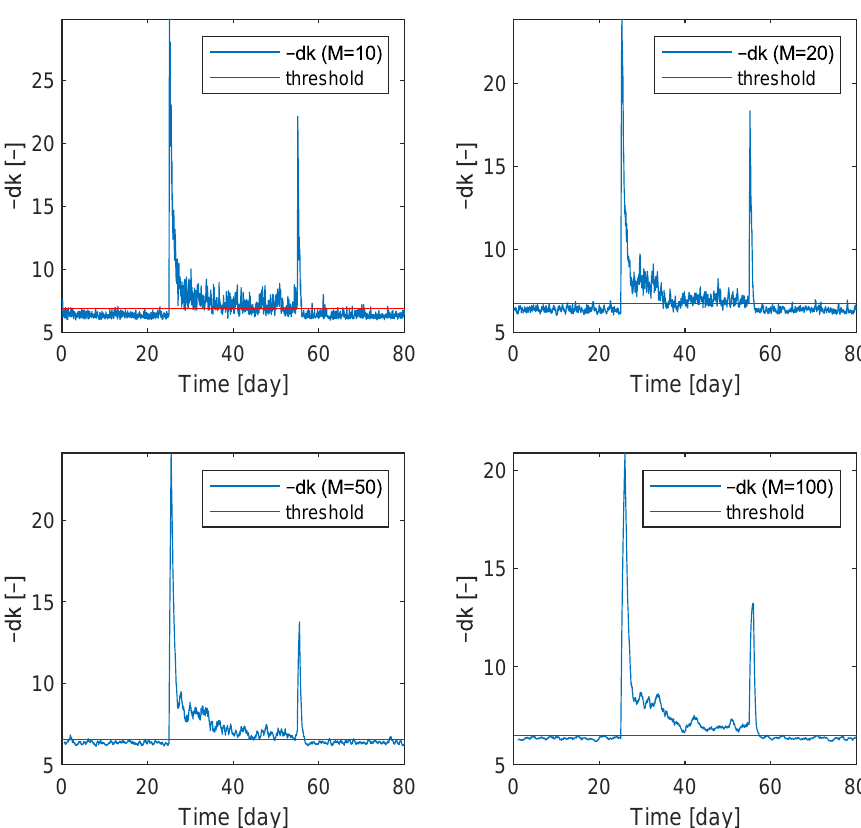
Figure 14. Sensitivity analysis by the sliding window ( M ): bias faults. Bias sensor faults are defined in the same way as above. M = 10, 20, 50, and 100 time steps. The 15% fault was used, that is, 990 mg MLSS/L. T = 8000.